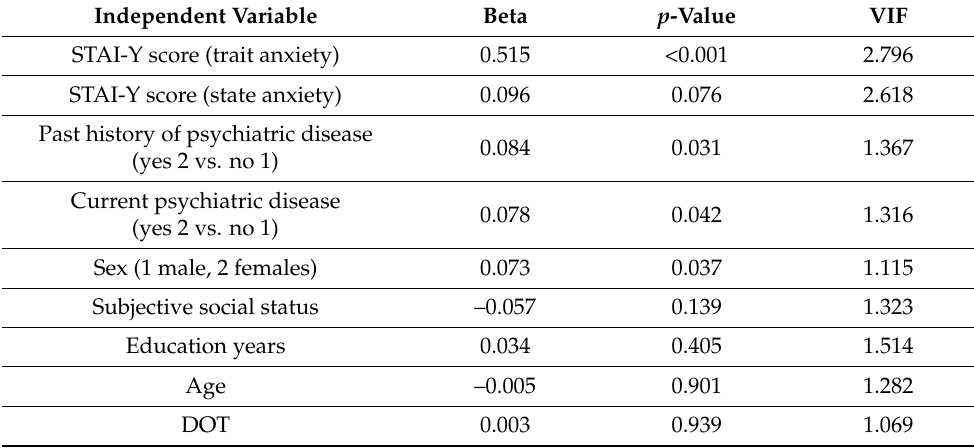
Table 2. Multiple regression analysis of the factors associated with depressive symptoms (PHQ-9 score).